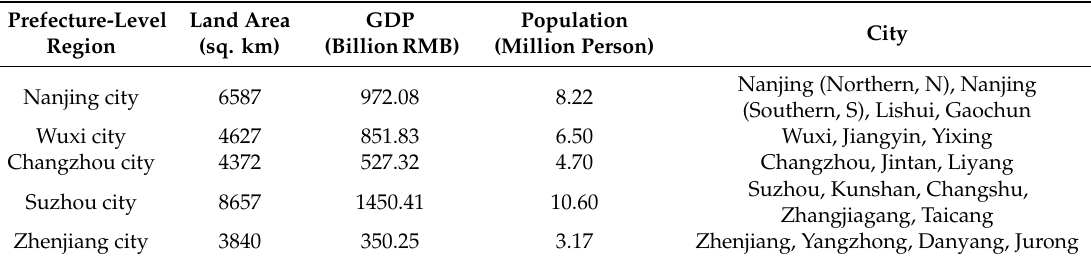
Figure 2. Location, administrative divisions and topography of Southern Jiangsu Urban Agglomeration (SJUA). Table 1. Administrative divisions and cities in SJUA, 2015.